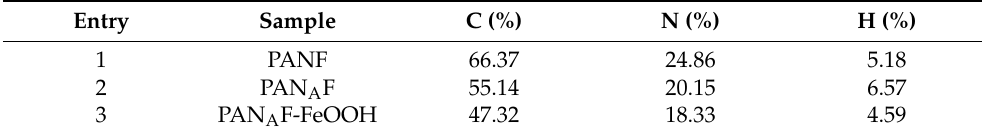
Table 1. Elemental analysis data for PANF, PAN A F, and PAN A